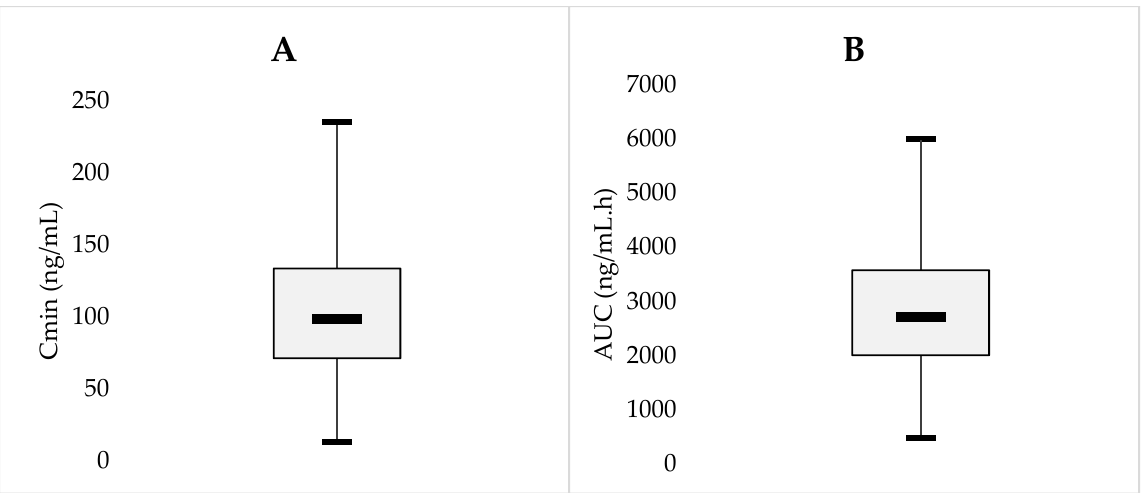
Figure 2 . ( A , B ) Inter-individual variability among patients in Cmin (A) and AUC T, SS (B) values . Figure 2. ( A , B ) Inter-individual variability among patients in Cmin ( A ) and AUC